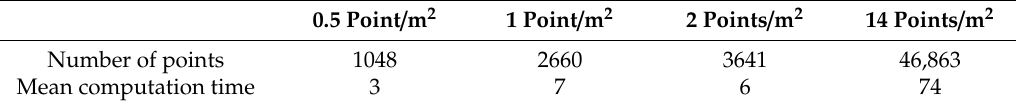
Table 9. Mean computation time (s) per point cloud density for residential